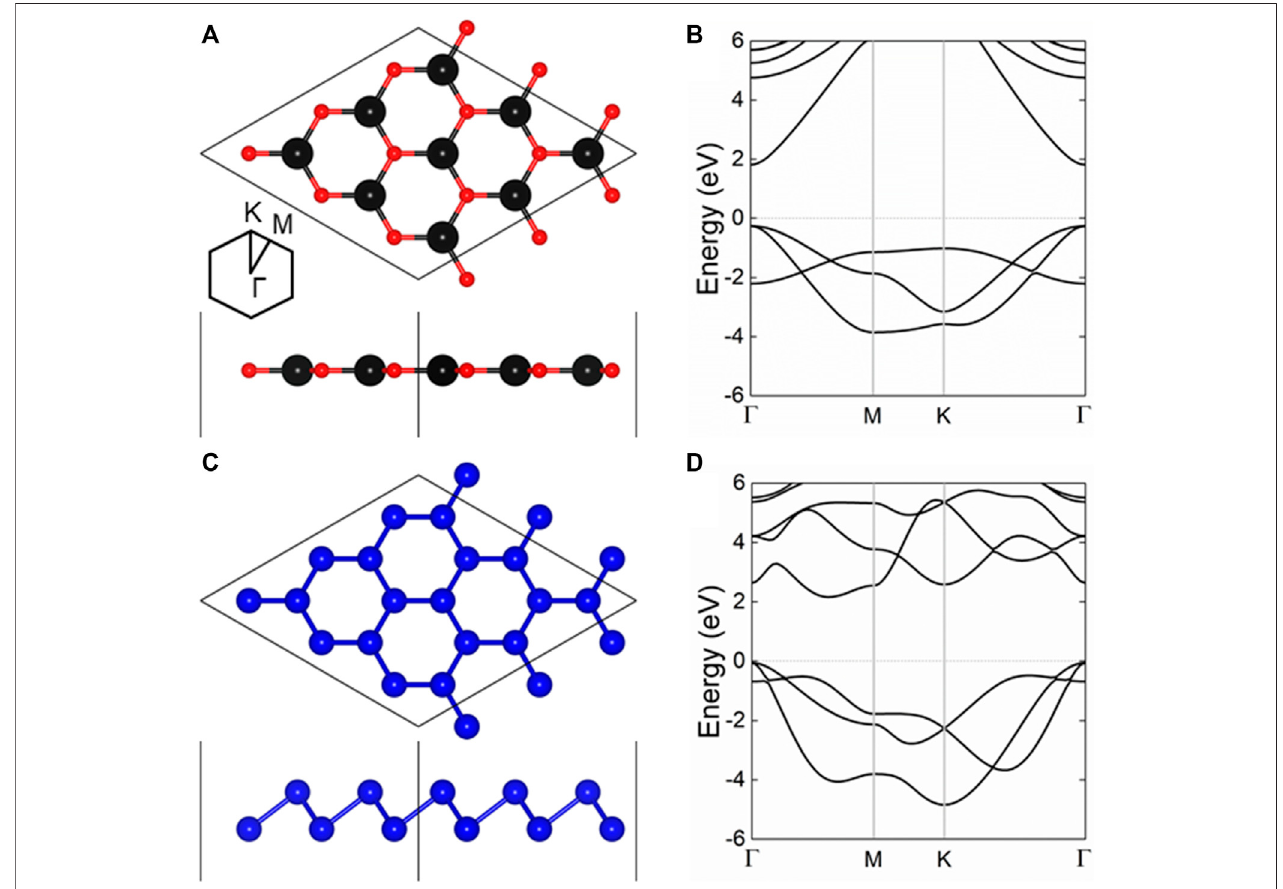
FIGURE1 | The (A,C) crystalstructureand the (B,D) bandstructure ofthe (A,B) CdO and (C,D) Asmonolayers;the black, red and blue balls represent Cd, Oand As atoms, respectively; the Fermi level is 0 shown as gray dashed line.